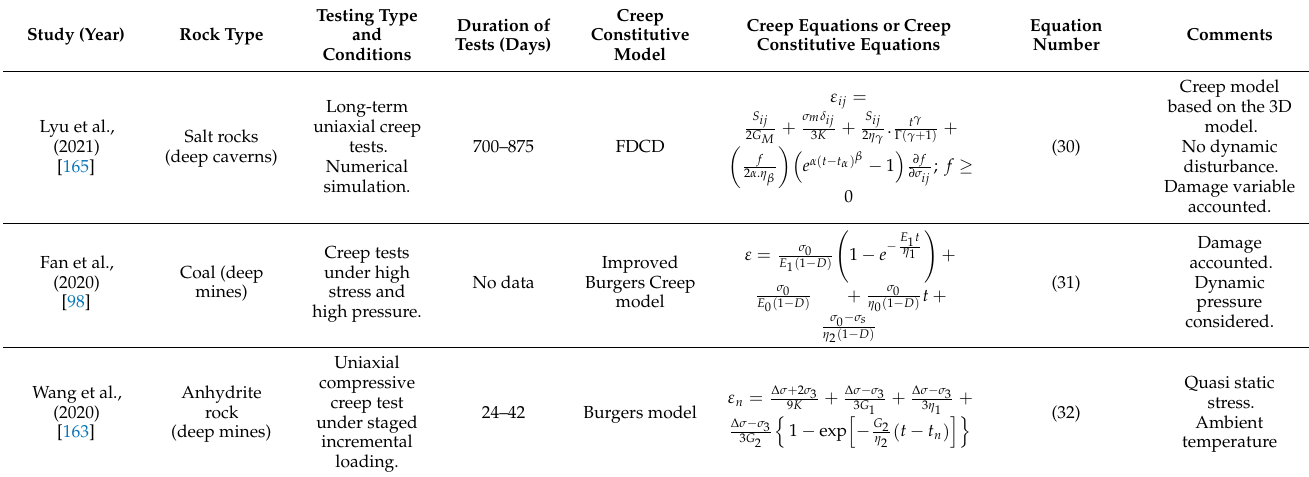
Table 6. Some existing creep constitutive models for mines and